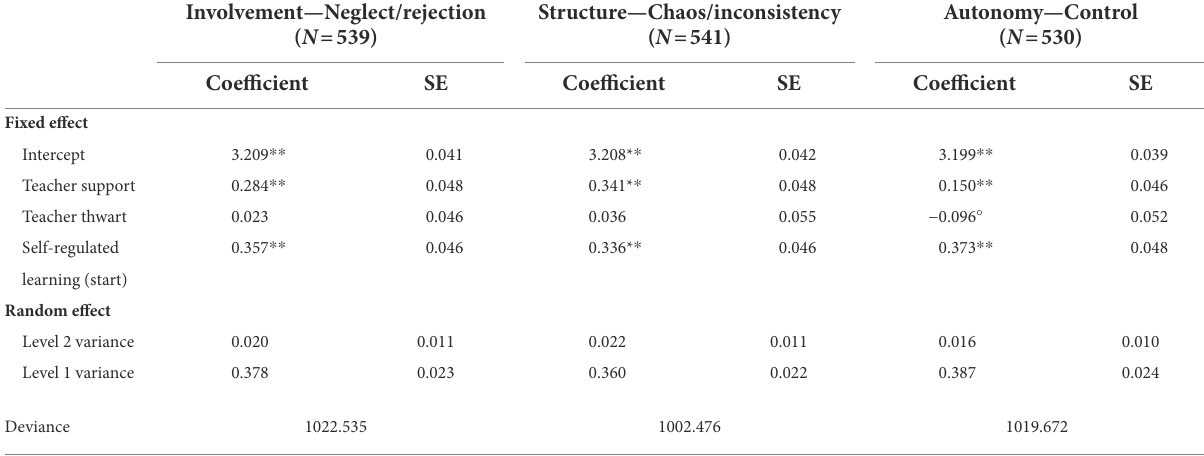
TABLE 2 Results of multilevel models explaining students’ self-regulated learning by teacher support and thwart dimensions and self-regulated learning at the start of the school year. Involvement—Neglect/rejection Structure—Chaos/inconsistency Autonomy—Control ( N = 539) ( N = 541) ( N =